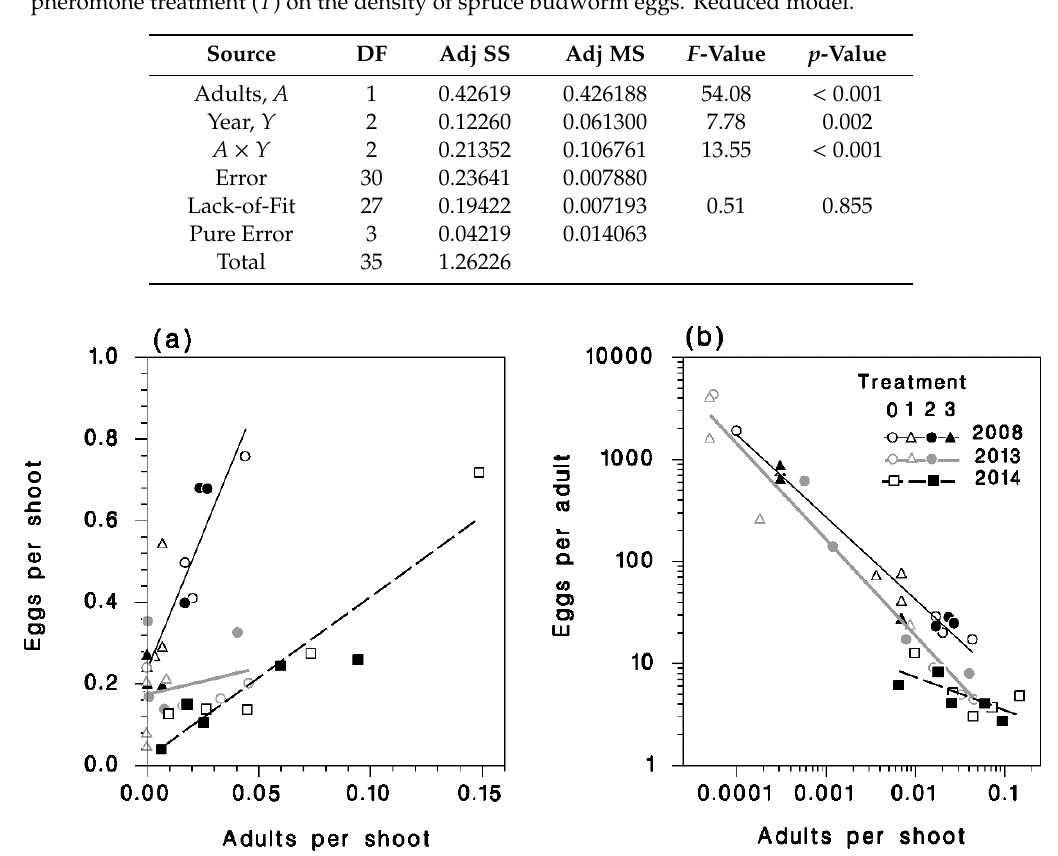
Table 3. General linear model (Equation (3)) of the e ff ects of emerging adult density ( A ), Year ( Y ) and pheromone treatment ( T ) on the density of spruce budworm eggs. Reduced model.